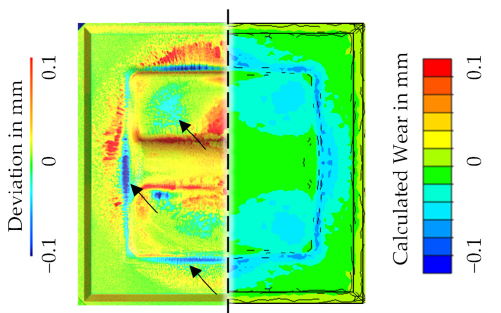
Figure 21. Comparison of the local topography deviations ( left ) and the numerical wear prediction ( right ) for the wear state after 2000 cycles.